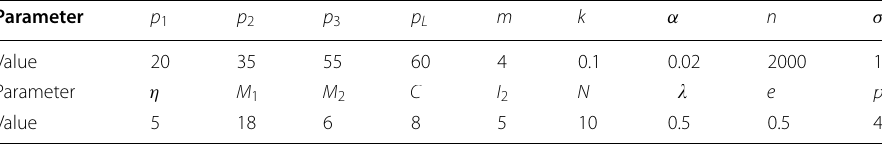
Table 4 List of determined value of parameters